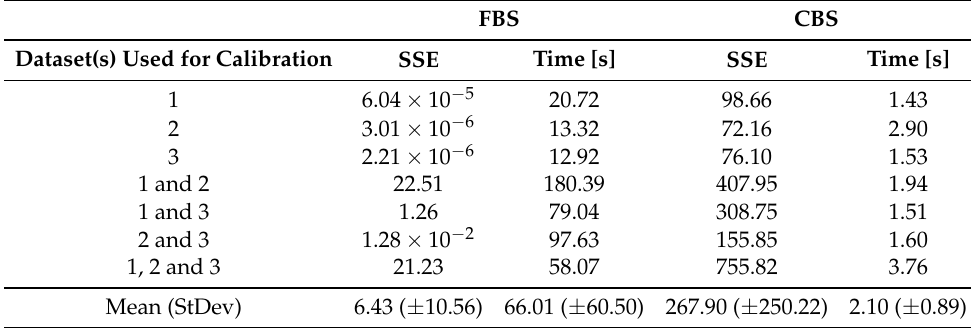
Table 2. Summary of SSEs and computation times using the FBS and CBS (Serra Leste).